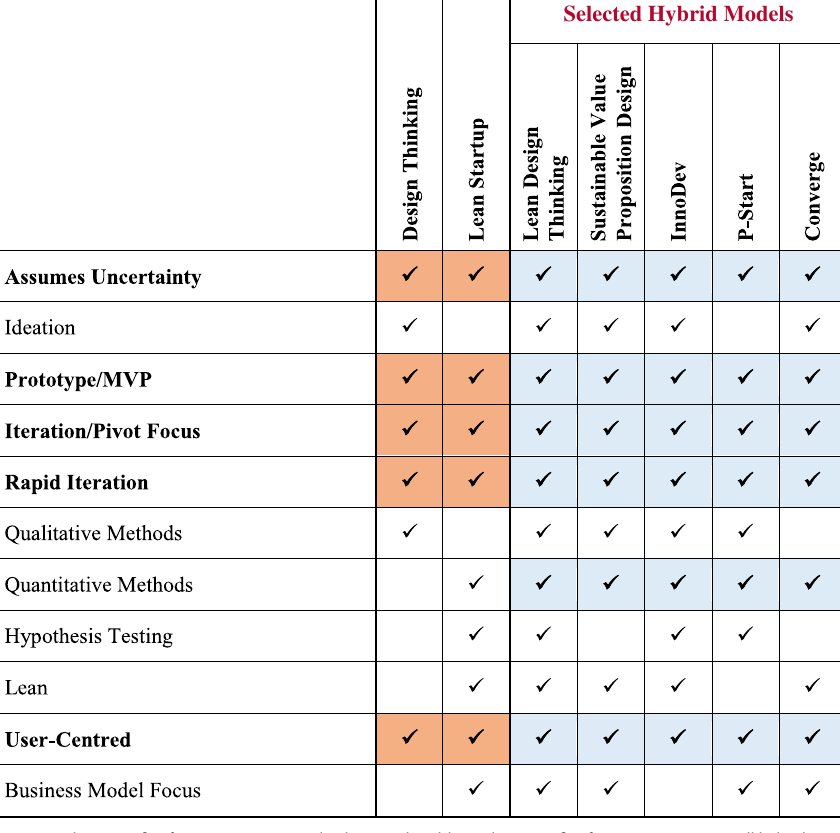
Selected Hybrid